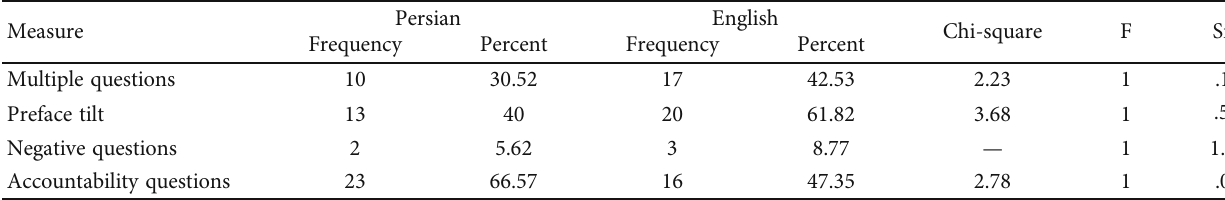
Table 4: Frequency of question design in Persian and English.